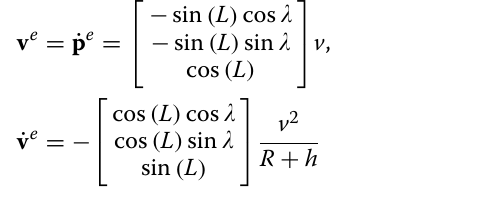
where the initial position has h 0 10,000 m, and v = and (8), the velocity in the Earth frame and its derivative are obtained as